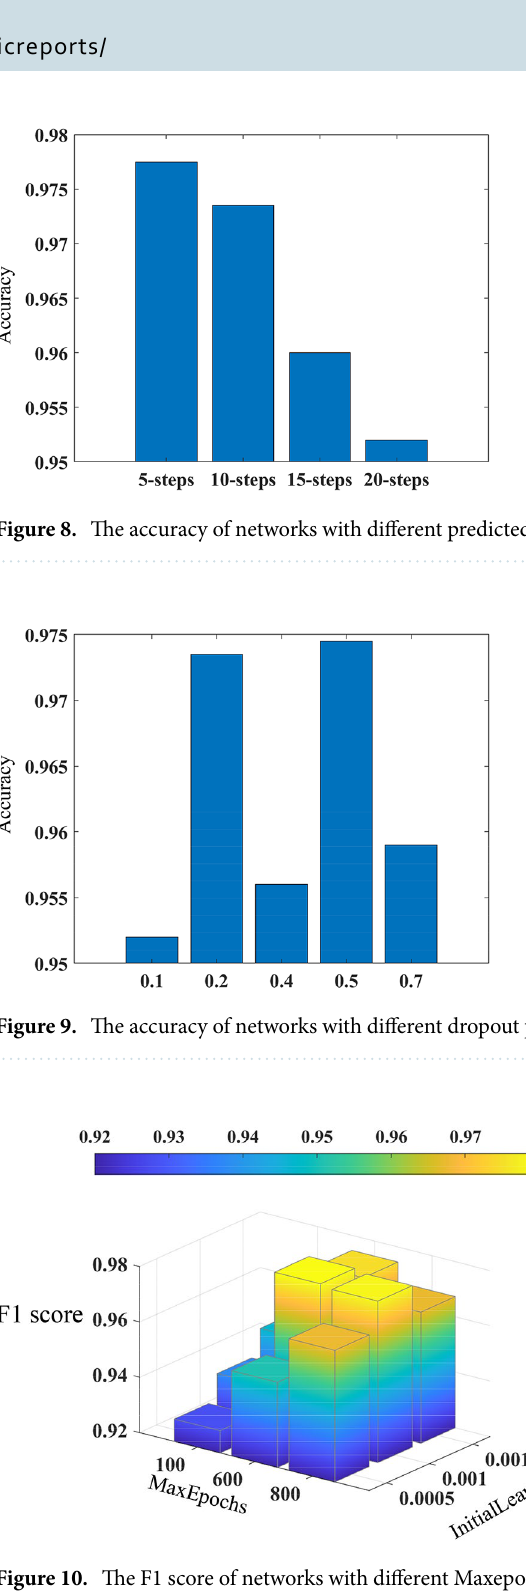
Figure 10. The F1 score of networks with different Maxepochs and